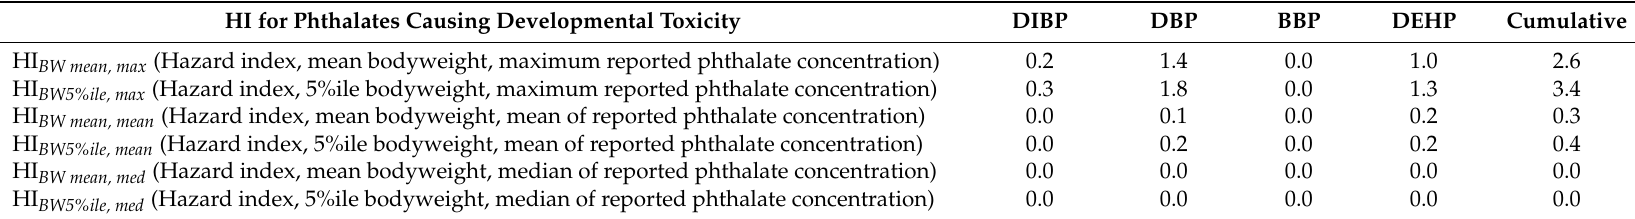
Table 6. HI values for cumulative exposure to DEHP, BBP, DBP, and DIBP through oral and dermal routes, using maximum, mean, and median concentrations in toys. HI for Phthalates Causing Developmental